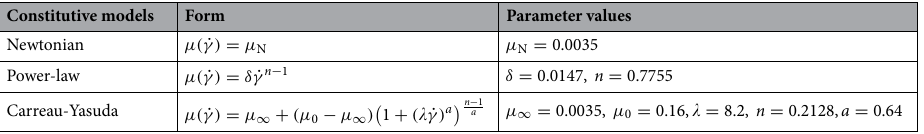
Table 1. Constitutive models and the associated parameter